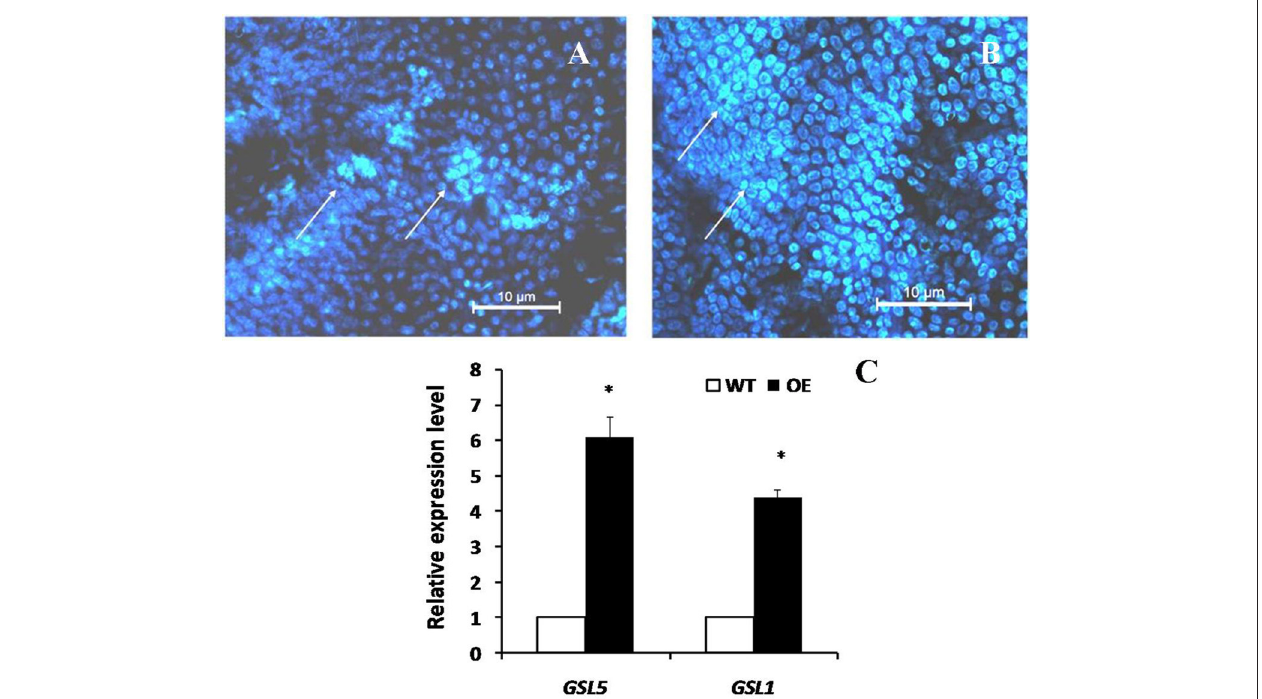
FIGURE 4 | Chromogenic assay of callose in leaves of the transgenic Arabidopsis plant and WT. Leaves of 4 weeks old were stained for 4h in darkness with aniline blue solution and deposition of callose in leaves was observed under fluorescence microscope of ultraviolet excitation. (A) Control (WT) (B) Transgenic Plant (C) Expression analysis of plant callose-related genes in transgenic (OE) and WT plants. Two callose synthase-encoding genes, GSL1 and GSL5 were analyzed. The AtActin8 gene was used as reference control. The data are the means ± SE from three independent experiments. The asterisks indicate statistically significant differences between the transgenic and control plants (ANOVA followed by Tukey’s tests, P < 0.05). Callose deposition were shown by arrows.